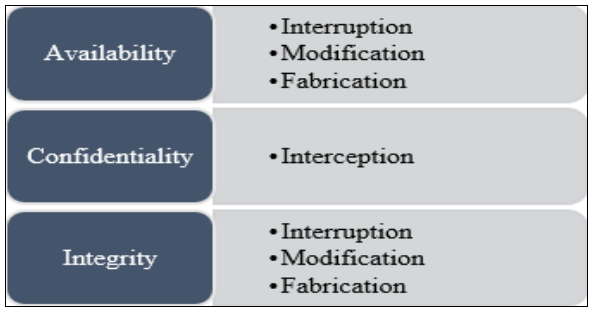
Figure 2. Goals of security